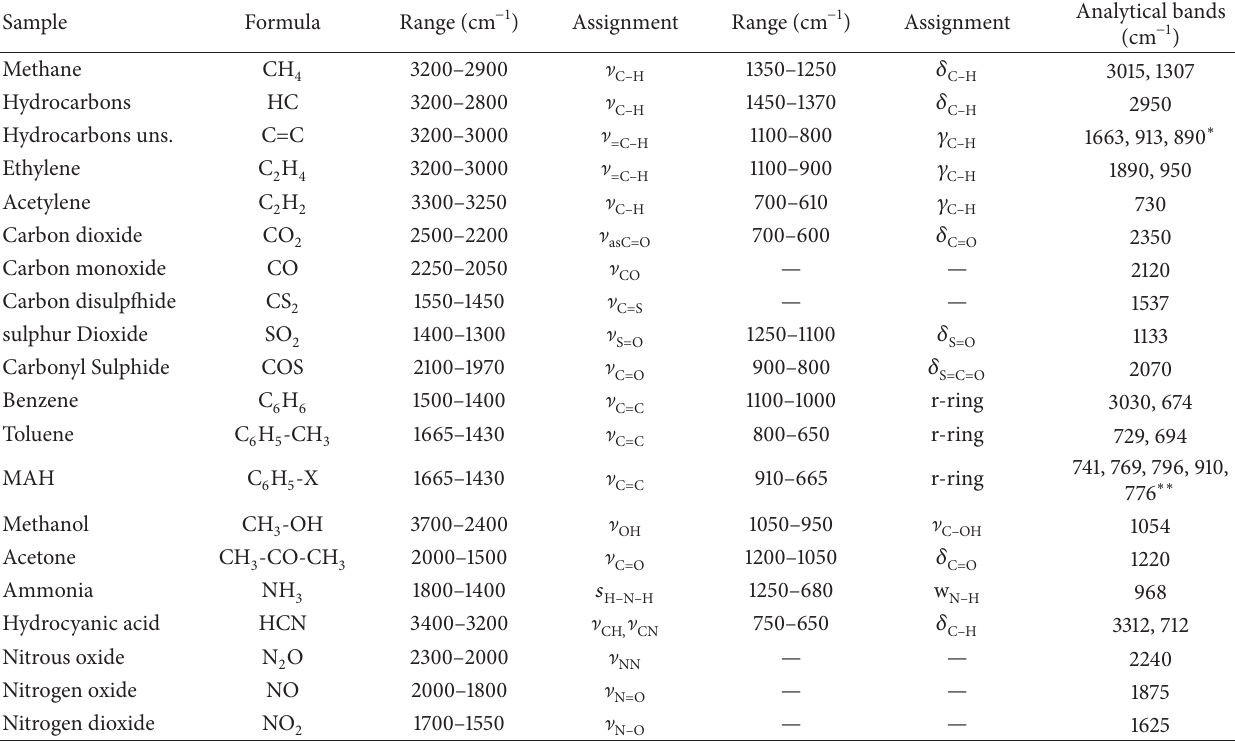
Table 3: Infrared absorptions range and analytical IR bands for considered vapors and